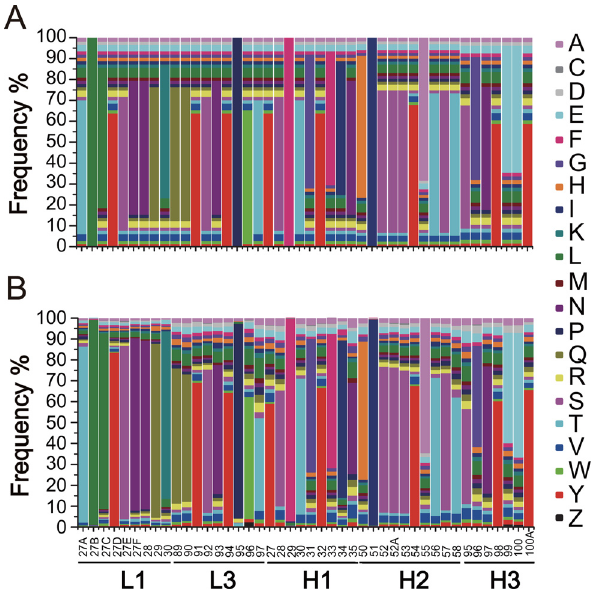
Fig 3. Amino acid composition at different CDR positions. (A) Map of the theoretical amino acid composition using NWG, NWC and NSG degenerate codons according to the SPM strategy. (B) Map of the observed amino acid composition from 10.3 million functional sequences in the unselected libraries. Forty diversified positions and four non-diversified positions are shown. Z represents a stop codon.